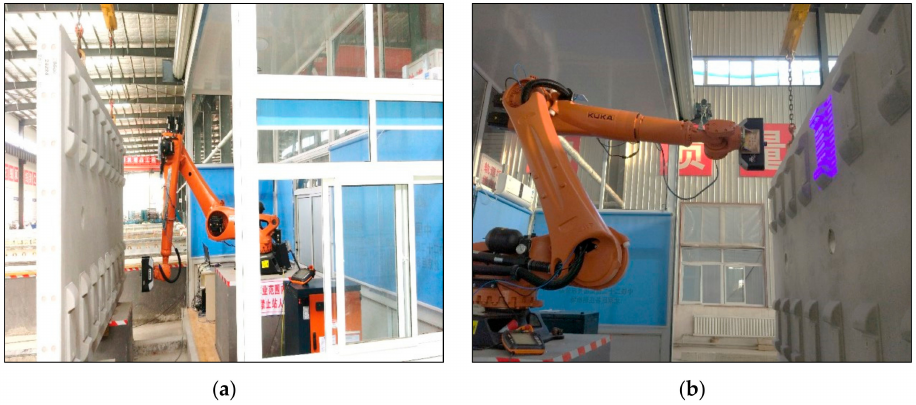
Figure 7. Operation field: ( a ) The detection system operation; ( b ) The data acquisition.